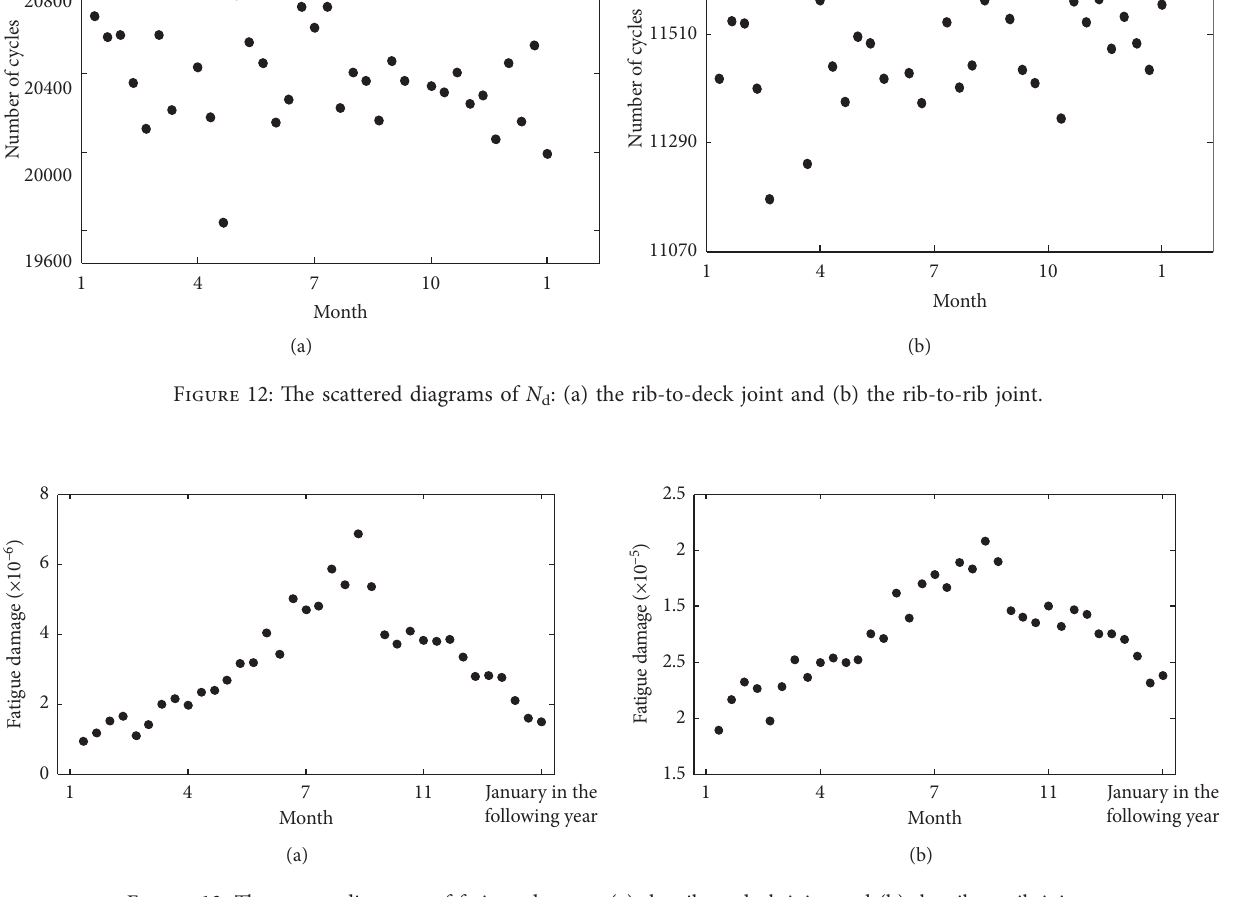
Figure 13: The scatter diagrams of fatigue damage: (a) the rib-to-deck joint and (b) the rib-to-rib joint.